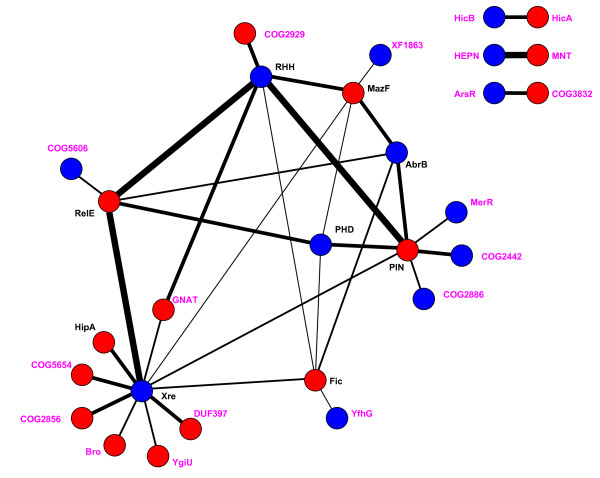
Graph of relationships between different families of toxins and antitoxins. Known (black) and predicted (magenta) toxins (red circles) and antitoxins (blue circles) and their operon organizations. Lines connect genes with 5 or more two-component operons found; thickness of a line is proportional to the frequency of the respective operon.